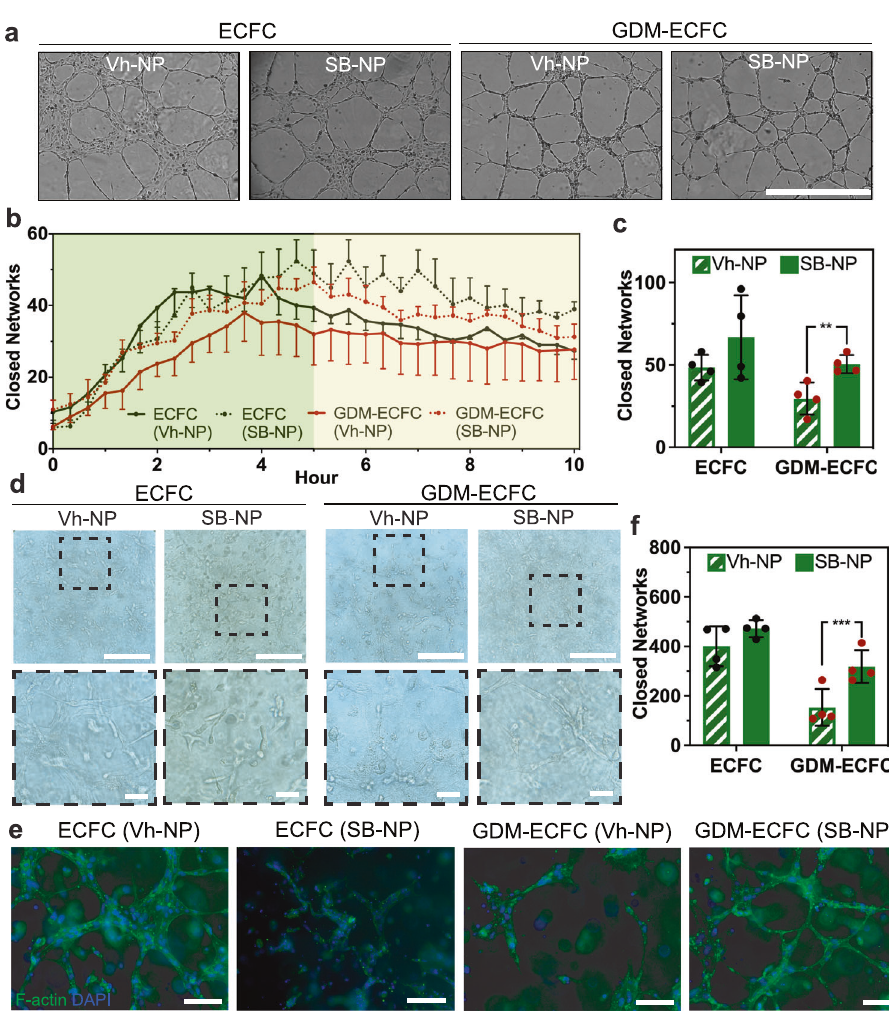
Fig. 5 Bioactive Nanoparticles Improve in vitro Vasculogenesis. a High contrast bright fi eld images of ECFCs and GDM-ECFCs vascular tube formation on Matrigel 5 h post plating following treatment with Vh-NPs or SB-NPs. Scale bar is 1 mm. b Kinetic analysis of vasculogenesis (KAV) identi fi es closed networks formed over time. c The number of closed networks 5 h post-plating were quanti fi ed and plotted. SB-NPs signi fi cantly improve closed networks formed by GDM-ECFCs (** P = 0.010), but not by normal ECFCs ( P = 0.218). Four biological replicates ( n = 4; mean ± s.d.) were used for normal ECFCs ( black data dots) and GDM-ECFCs ( red data dots). d High contrast bright fi eld images of ECFCs and GDM-ECFCs forming 3D vascular networks in collagen at 48 h post encapsulation following conjugation with Vh-NPs or SB-NPs. High magni fi cation images of the dashed areas depict the vascular tube networks. Scale bars are 100 µ m. e Fluorescent images of ECFCs and GDM-ECFCs forming 3D vascular networks were stained for F-actin (green) and nuclei (blue). Scale bars are 50 µ m. f The number of closed networks 48 h post encapsulation were quanti fi ed and plotted. Four biological replicates ( n = 4; mean ± s.d.) were used for normal ECFCs ( black data dots) and GDM-ECFCs ( red data dots). SB-NPs signi fi cantly improve closed networks formed by GDM-ECFCs (*** P = 0.0031), but not by normal ECFCs ( P = 0.051). Statistical signi fi cance was evaluated using Student ’ s t -test. Signi fi cance levels were set at * P < 0.05, ** P < 0.01, *** P <